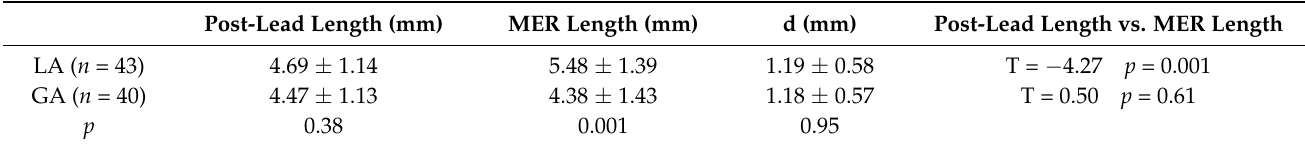
Table 2. Comparison of the vector of deviation (d) between two groups; cross comparison of electrode length and MER length between two groups.